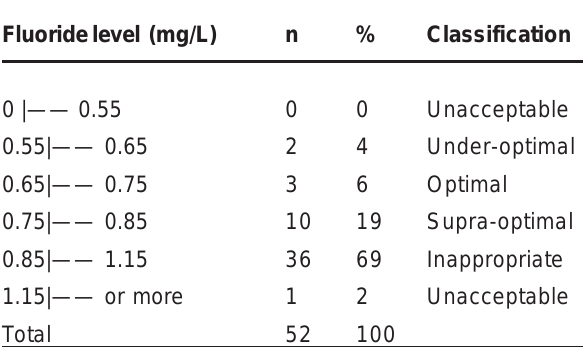
TABLE 1- Classification of water samples, n and %, according to fluoride levels, Bauru,